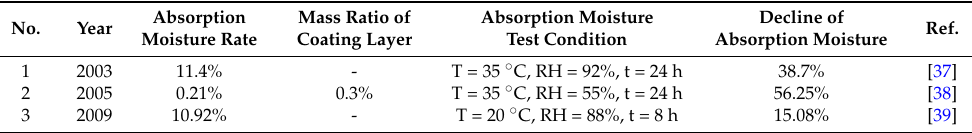
Table 2. Performance of coated AN using the chemical coating method.